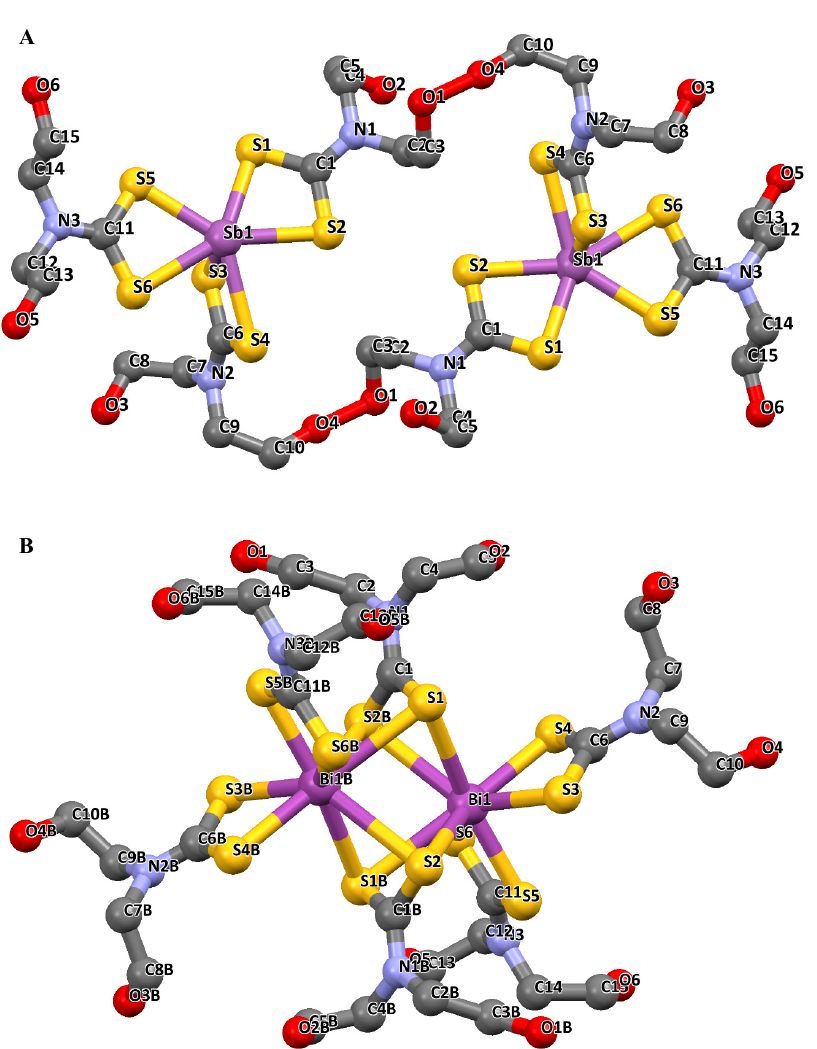
Figure 5. ( A ) Crystal structure and the labelling scheme of [Sb(deadtc) 3 ]. ( B ) Crystal structure and the labelling scheme of the two crystallographyically independent units of [Bi(deadtc) 6 ]. Unlabelled atoms are related by symmetry operation to labelled atoms. Redrawn from [60], with permission from Elsevier (copyright 2019).